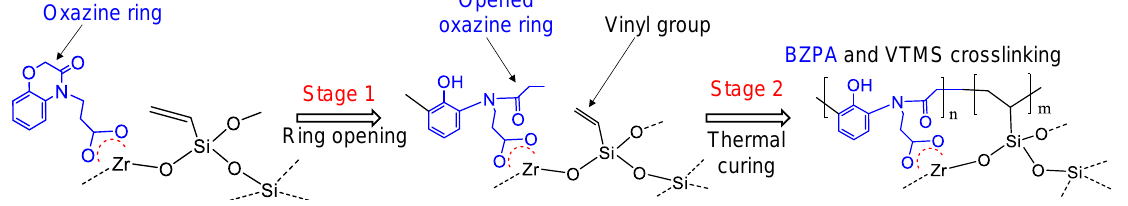
Figure 2. Schematic representation of the thermal crosslinking of the vinyl group of VTMS and of the